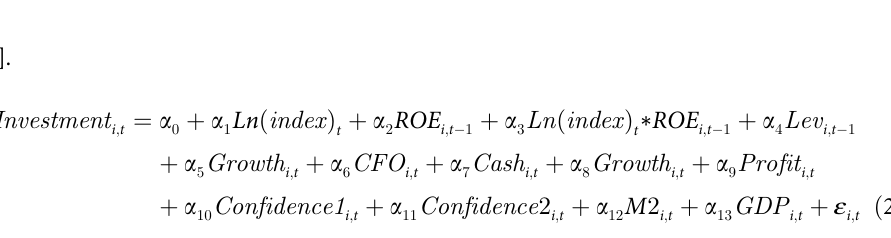
The investment efficiency variable is examined using the sensitivity between investment expenditure ( Investment ) and profitability ( ROE ), and the coefficient of interaction term α of 3 ROE and policy index ( Ln(index) ) is the main test variable. On the basis of Hypothesis 1, we expect the coefficient of α to be significantly greater than zero (i.e., fiscal and financial policies 3 will have a significant incentive effect on the investment efficiency of SMEs). For all following regressions, fixed effects regression models that control for individuals and provinces are used and time fixed effects are not controlled for. Because the paper’s policy index ( Ln(index) ) is a macro variable in the time series, controlling for time fixed effects would produce perfect col- linearity and lead to nonsense parameters. The baseline regression results are reported in Table 4, where column (1) does not include any control variables, and the coefficient of the interaction term Ln(index) * ROE is significantly positive at the 1% significance level, indicating that fiscal and financial policies enhance the sensitivity between SME investment and profit- ability, and suggest investment efficiency is positively incentivized. Columns (2) and (3) incor- porates firm-level and macro-level control variables respectively; and Columns (4) controls for both micro and macro factors. As can be seen, the coefficient of interaction term between investment level and ROE remains significantly positive after the inclusion of the control vari- ables, and there is no significant change in the significance and coefficient. This is consistent with our expectation, and Hypothesis 1 is supported.